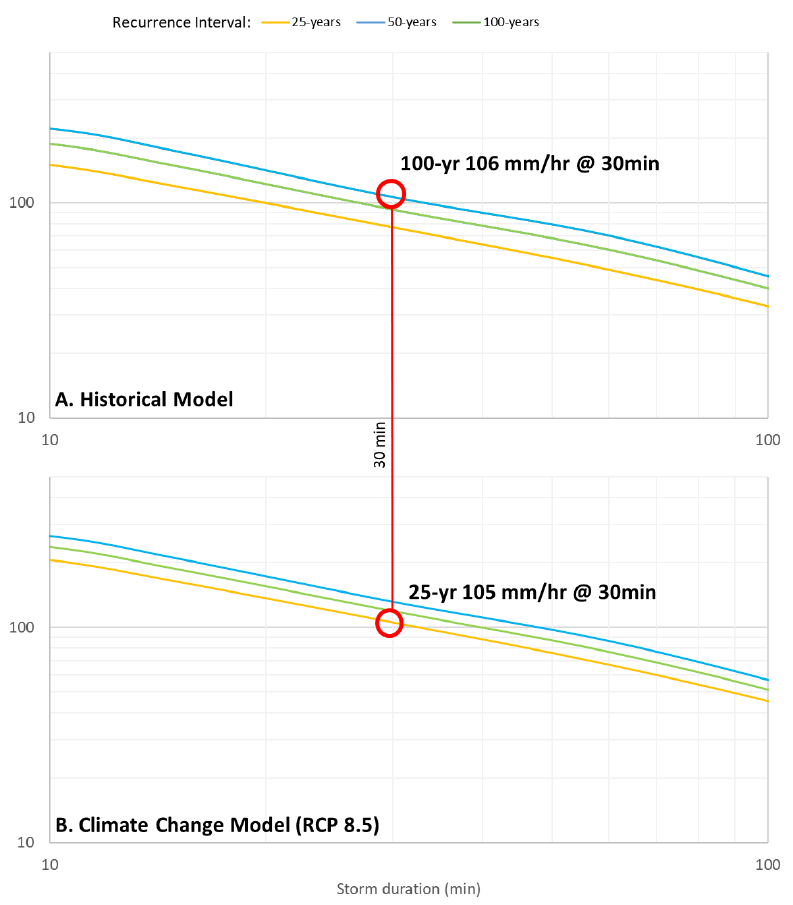
Figure 6. Selected IDF curves comparing historical model and climate change model (vertical axis is the rainfall intensity with unit mm/h).